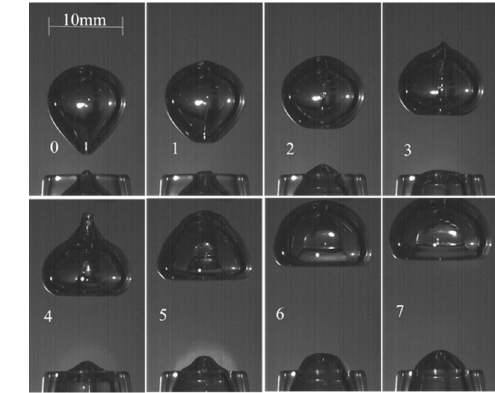
Figure 6. Density and pressure variation in computational fluid dynamics (CFD), φ = 6 mm. ( a ) Density of water and air bubble. ( b ) Pressure. ( c ) Data sampling timing on pressure diagram at measuring